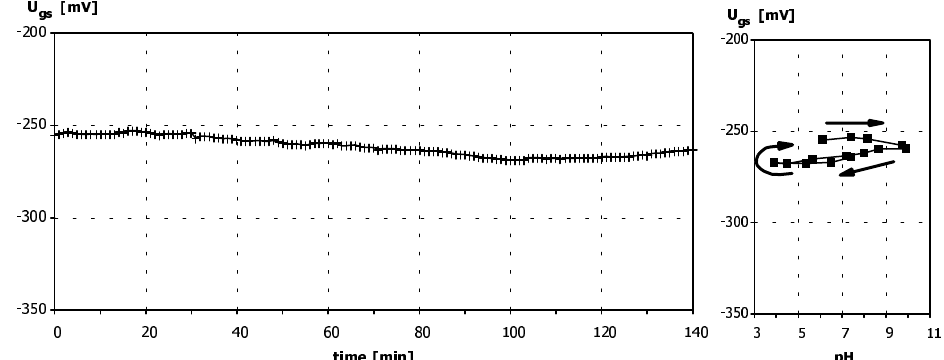
Figure 6. Dynamic response and calibration curve to pH of an ISFET with polyHEMA coating ca. 100 µm thick, deposited according to the Method 3. Cycle of pH changes: 6-10-4-7.